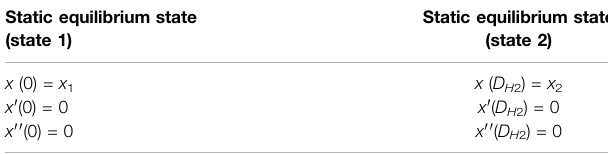
TABLE 8 | Motion subphase conditions (horizontal movement). Static equilibrium state (state 1)